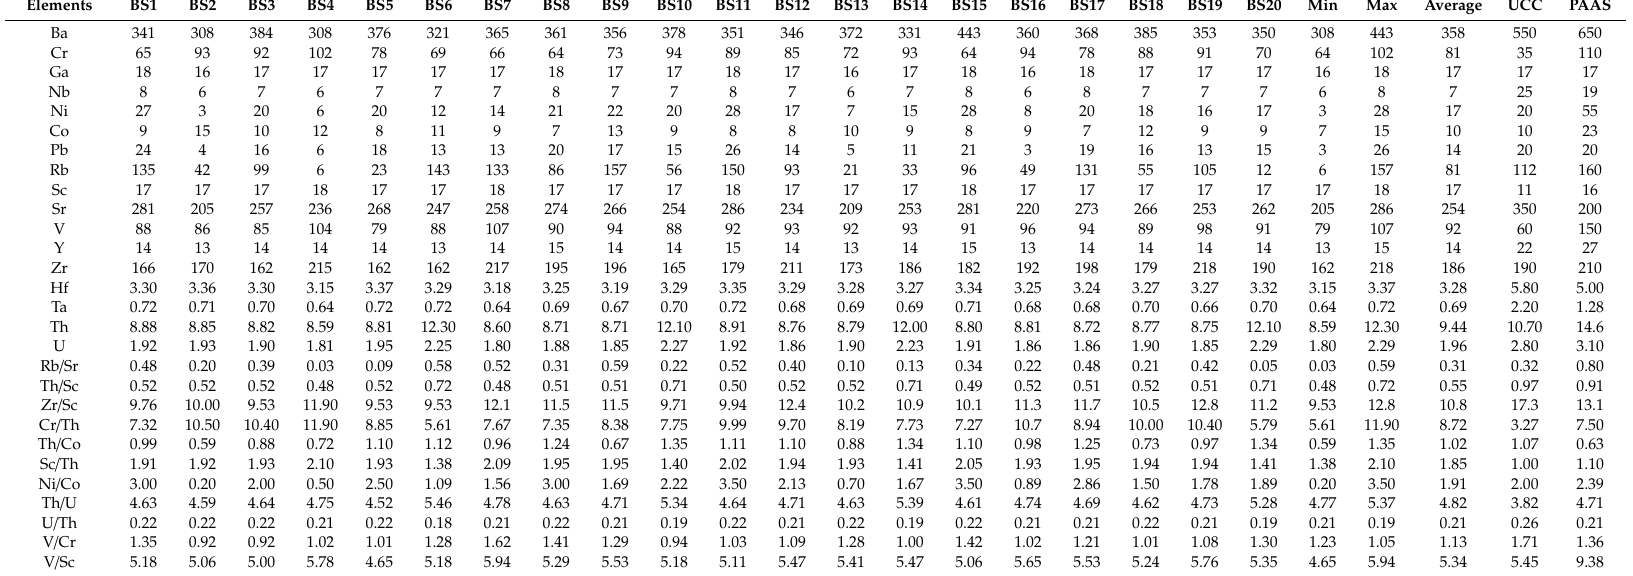
Table 2. Trace element compositions (ppm) and selected elemental ratios of the Brahmaputra River